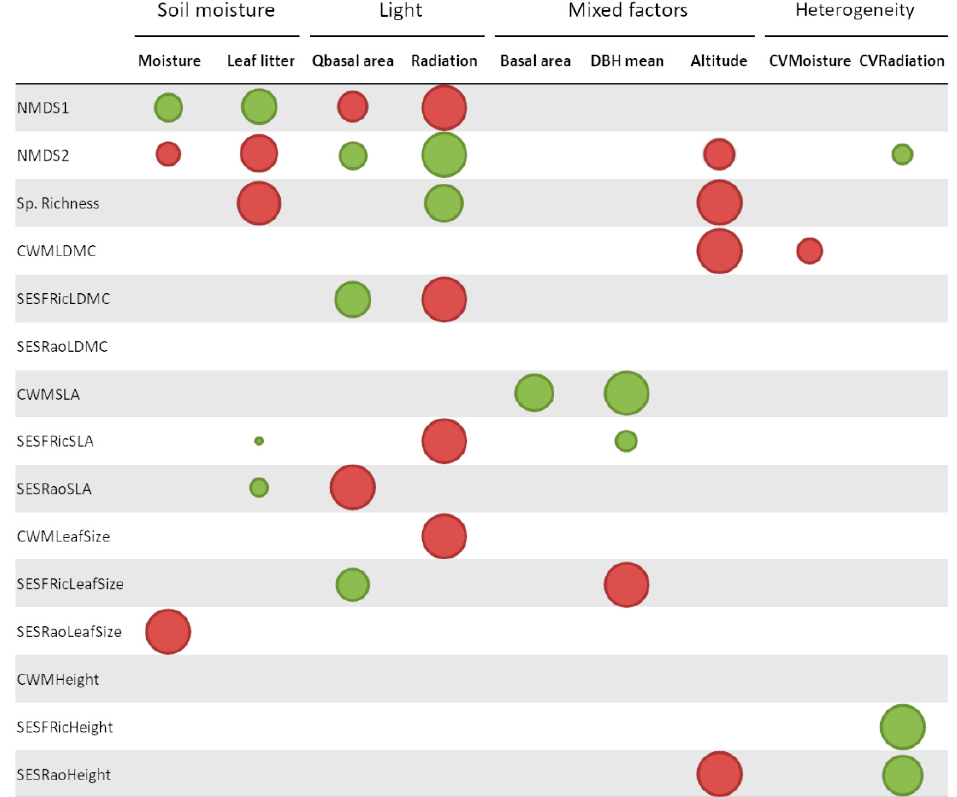
Figure 2. Relative influence of environmental factors (in columns) on different characteristics of the herb-layer. Such characteristics are taxonomic (first and second ordination axes scores, herb-layer species richness) and functional indices (CWM: functional composition; SESFRic: standardized effect size of functional richness; SESRao: standardized effect size of functional diversity) for LDMC (leaf dry matter content), SLA (specific leaf area), leaf size, and plant height. The environmental factors are classified according to the main resource to which they are more related (soil moisture, light, mixed factors, heterogeneity). The circle size is proportional to the values of correlation or regression coefficients for each model, while color indicates the sign of the relationship (red: negative relationship, green: positive relationship).